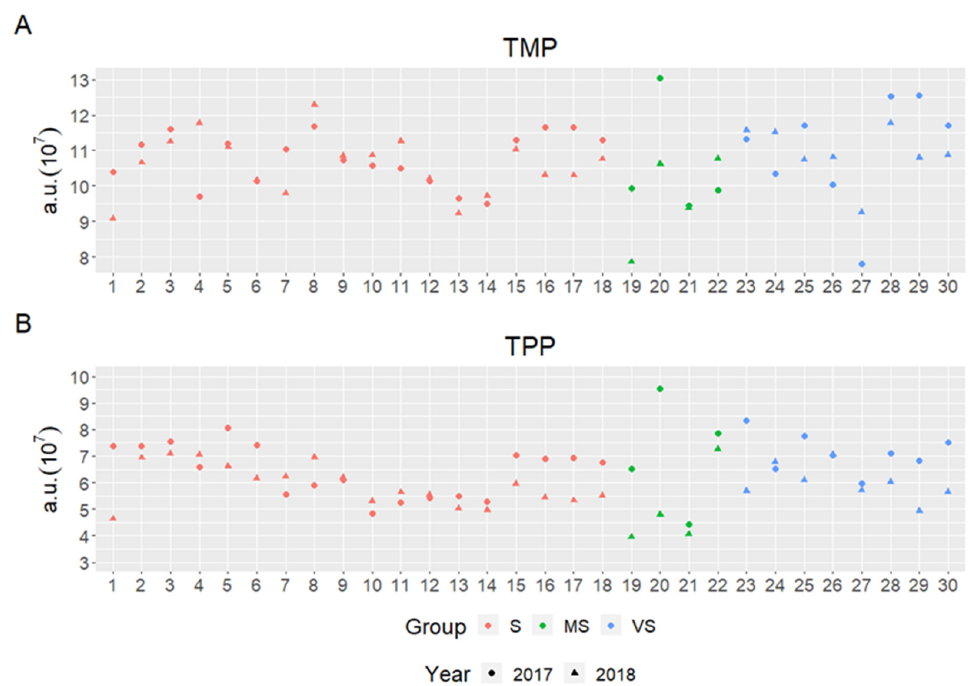
Figure 4. Total amount of monomeric proteins (TMP) ( A ) and total amount of polymeric proteins (TPP) ( B ) in dough of wheat samples shown in Groups S, MS, and VS of 30 spring wheat genotypes grown in cool (2017) and heat–drought (2018) years.